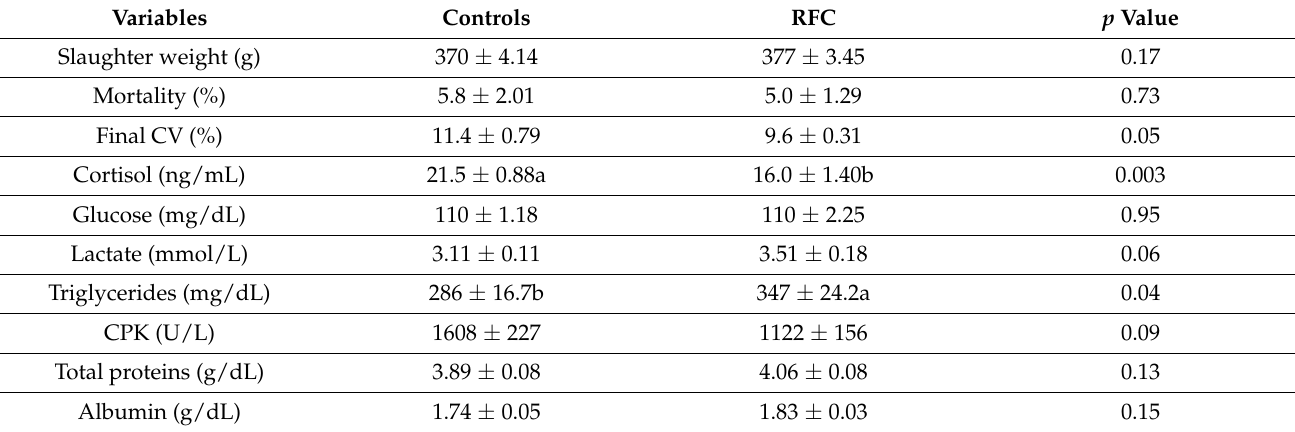
Table 3. Means ( ± SEM) of production and haematological parameters of rainbow trout from Trial 2 with constant currents (controls) or randomly fired currents (RFC), including significance. Different letters on the same row indicate significant differences due to current treatment ( p <